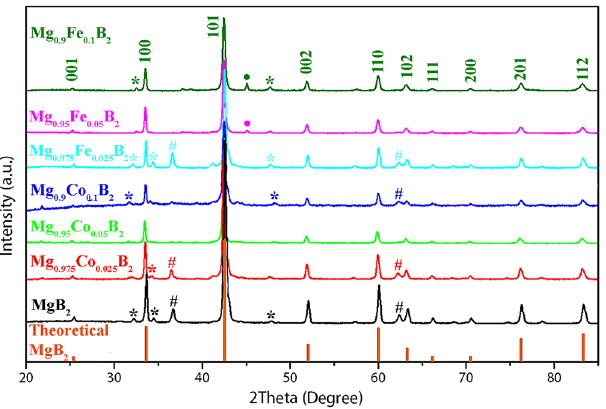
Figure 1. XRD patterns of MgB 2 and Mg 1− x TM x B 2 ( x = 0.025, 0.05, and 0.1; TM = Fe and Co): impurity peaks of Mg, MgO, and FeB/Fe 2 B are marked by *, #, and •,